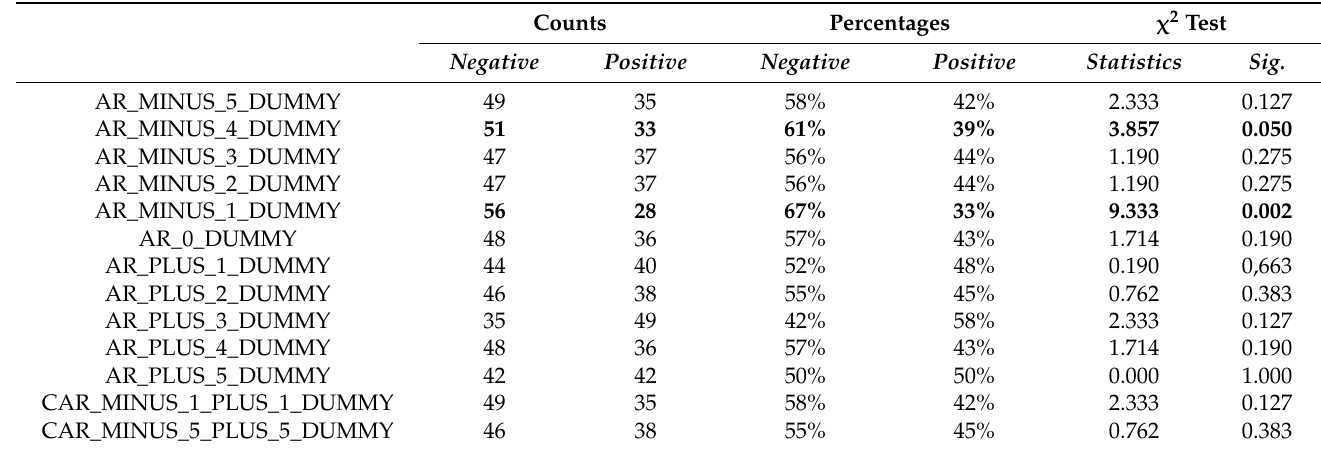
Table 8. Proportion of cases with negative and positive abnormal returns and χ 2